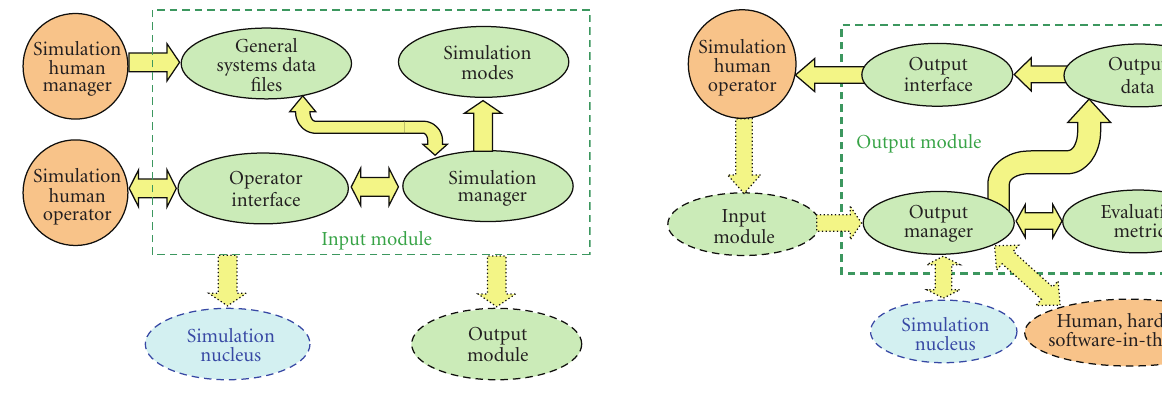
Figure 2: UAS-SE—input module. Figure 3: UAS-SE—output